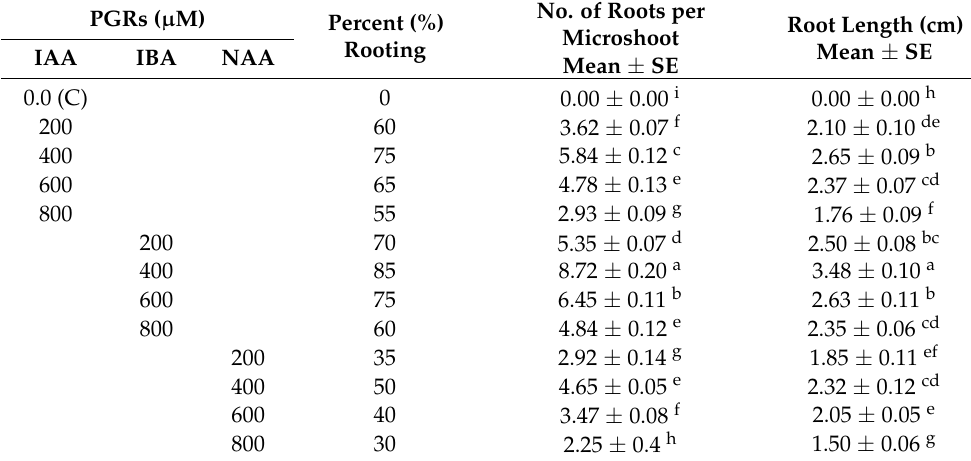
Table 5. Effect of different auxins on ex vitro root induction in tissue culture-raised microshoots of L. speciosa after 4 weeks of